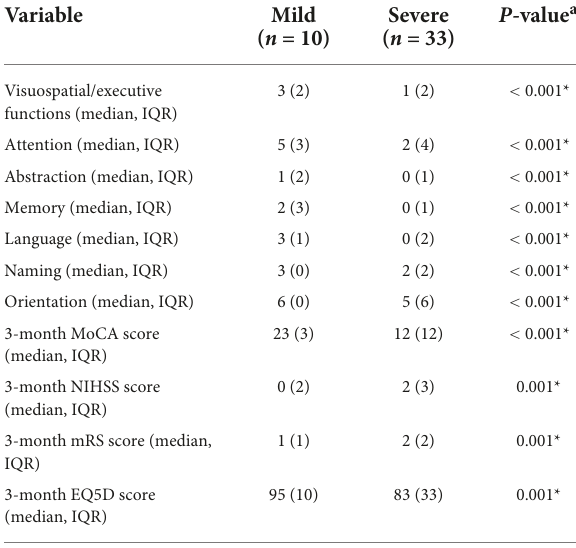
TABLE 3 The 3-month score of included PSCI